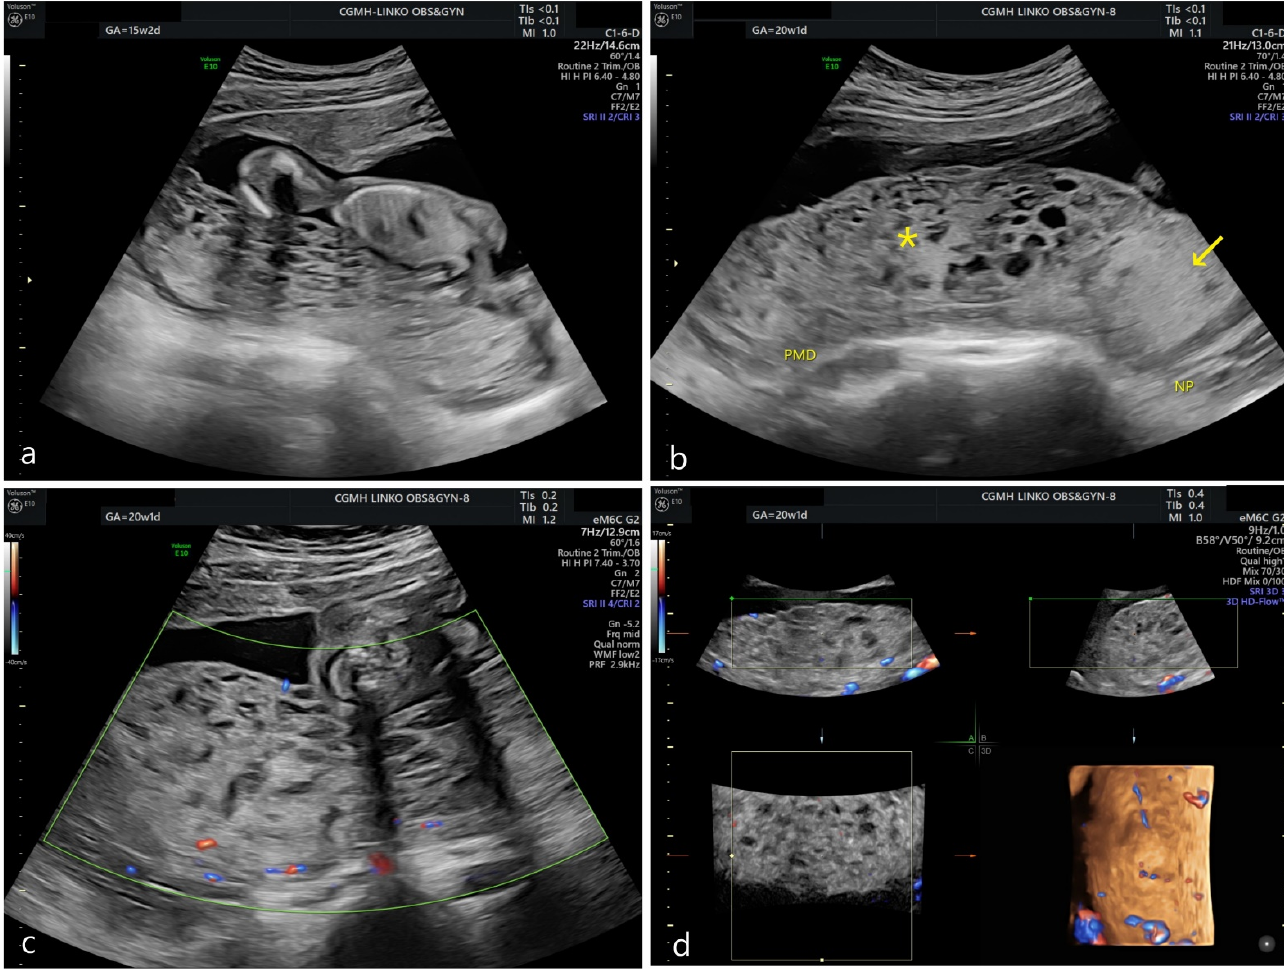
Figure 1. Prenatal ultrasonography. ( a ) At 15 weeks of gestation, multicystic change of placenta could be seen. ( b ) At 20 weeks of gestation, an enlarged dysplastic portion of the placenta was detected. (star*: dysplastic placenta; arrow: non-dysplastic placenta; PMD: placental mesenchymal dysplasia; NP: normal placenta) ( c ) Under Doppler scan, the dysplastic placenta showed low vascularity. ( d ) Under 3D reconstruction, the dysplastic placenta remained avascular.